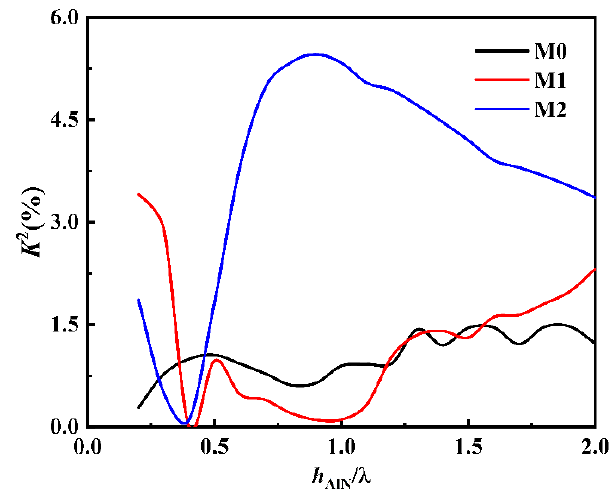
Figure 8. Curve characteristics of K 2 against h AlN / λ .